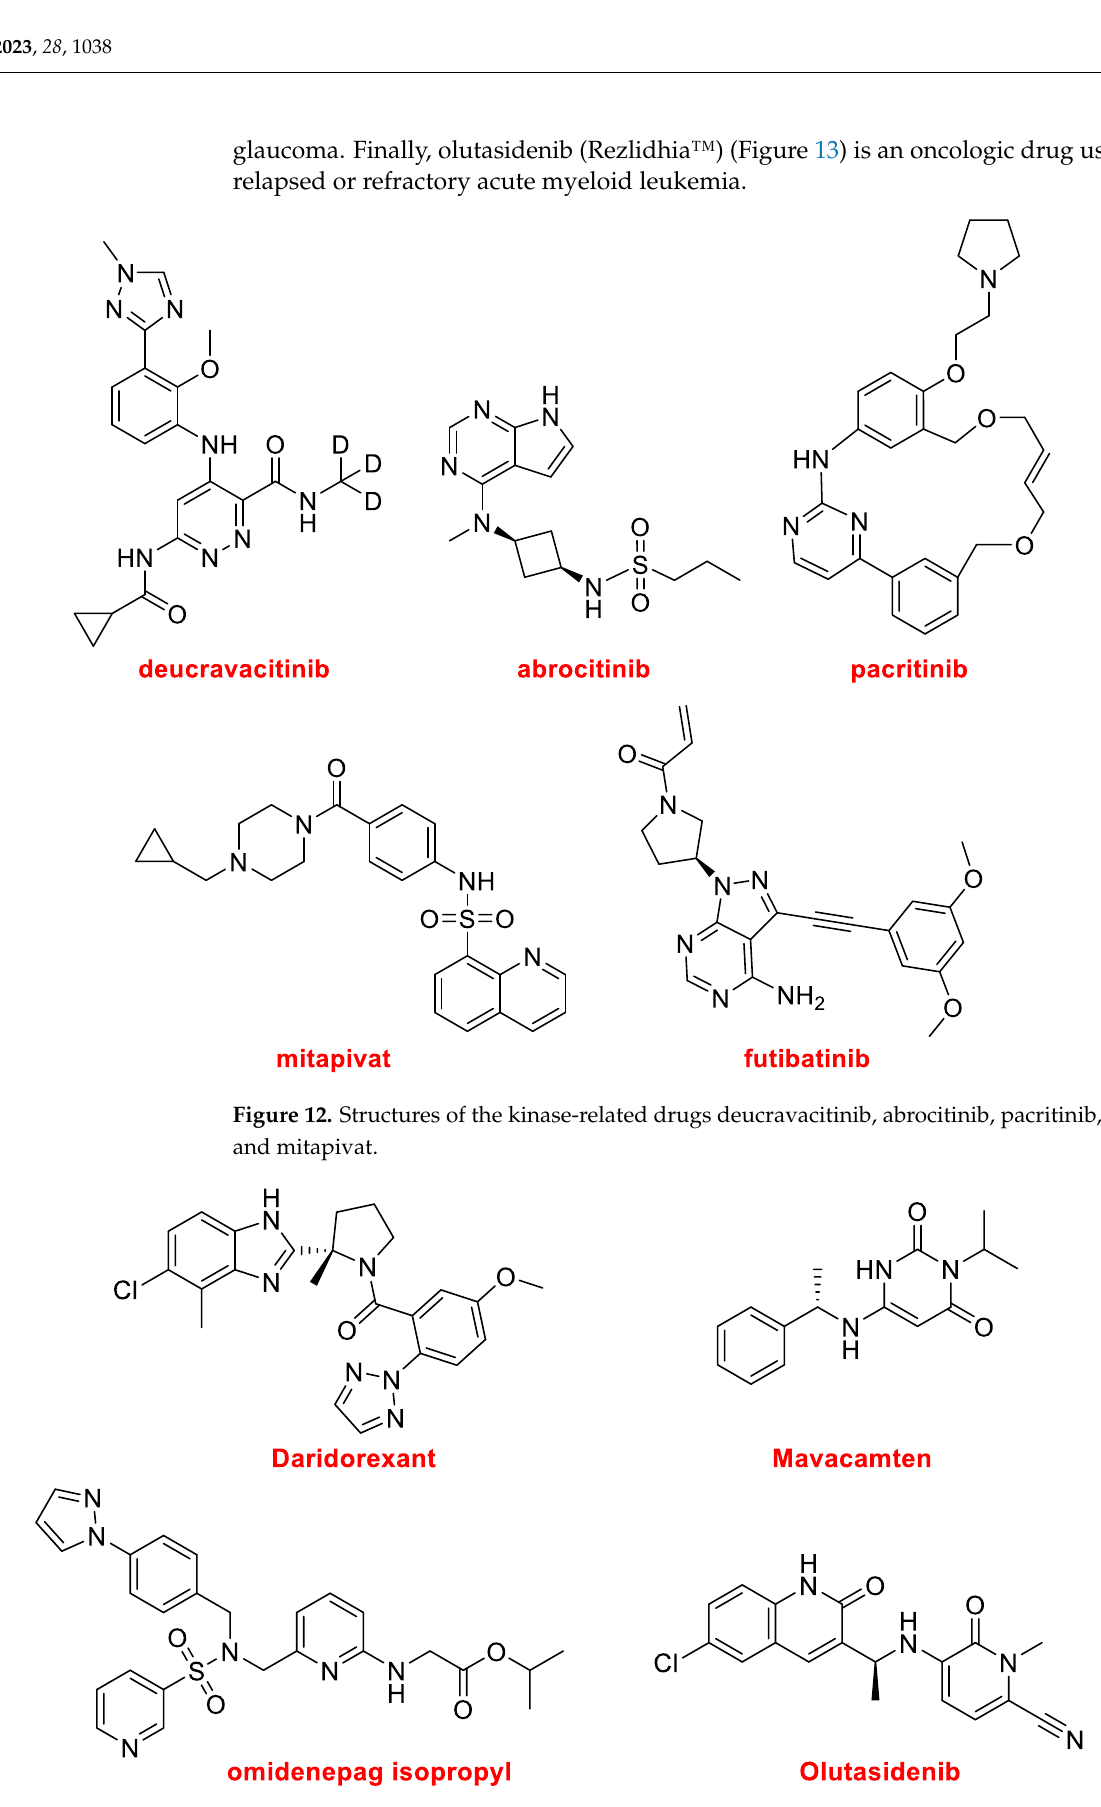
Figure 13. Structures of additional nitrogen aromatic heterocycle-based drugs.